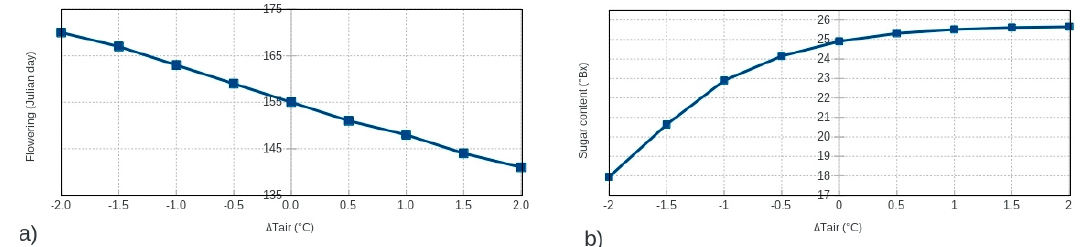
Figure 5. Sensitivity to changes of air temperature on the date of the flowering phase (expressed in Julian days) ( a ) and on the berry sugar content (in °Bx) evaluated at the 287th Julian day (corresponding to October 14th) ( b ). Δ T air is the difference between the input temperature and the actual temperature record.